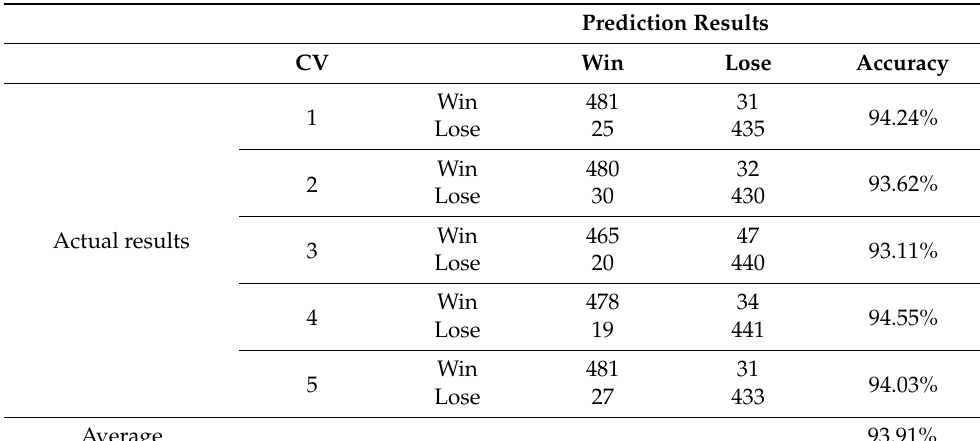
Table 12. Confusion matrix of ANN without feature selection (dataset